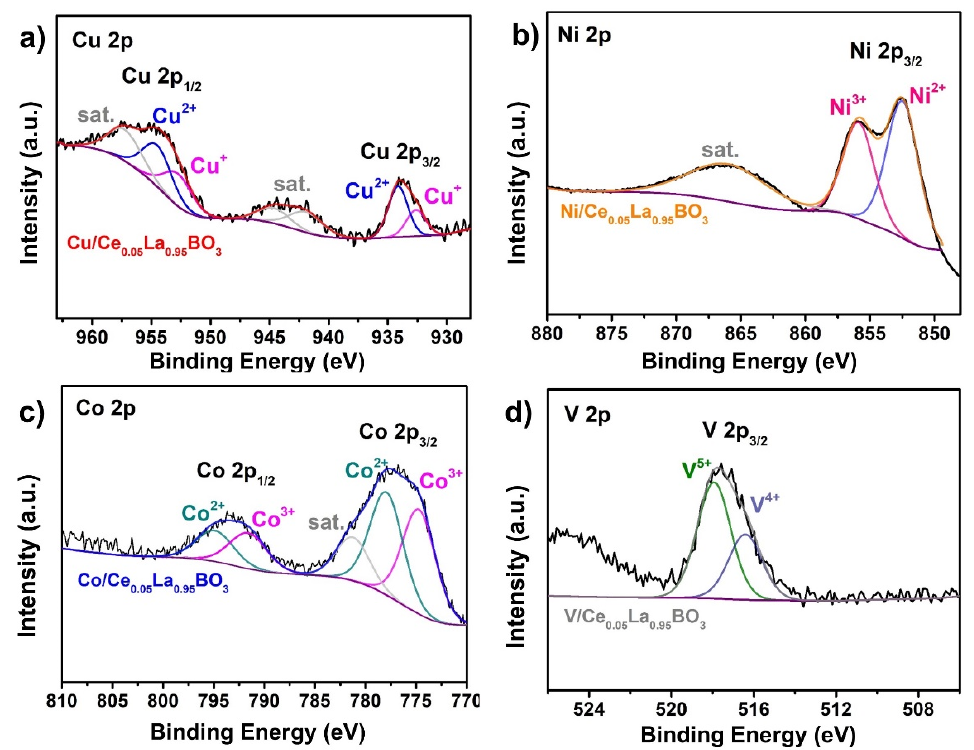
Figure 5. XPS spectra of different catalysts: ( a ) Cu 2p in Cu/Ce 0.05 La 0.95 BO 3 , ( b ) Ni 2p in Ni/Ce 0.05 La 0.95 BO 3 , ( c ) Co 2p in Co/Ce 0.05 La 0.95 BO 3 , and ( d ) V 2p in V/Ce 0.05 La 0.95 BO 3 . Table 1. The surface composition of surface elements in Cu/Ce 0.05 La 0.95 BO 3 , Ni/Ce 0.05 La 0.95 BO 3